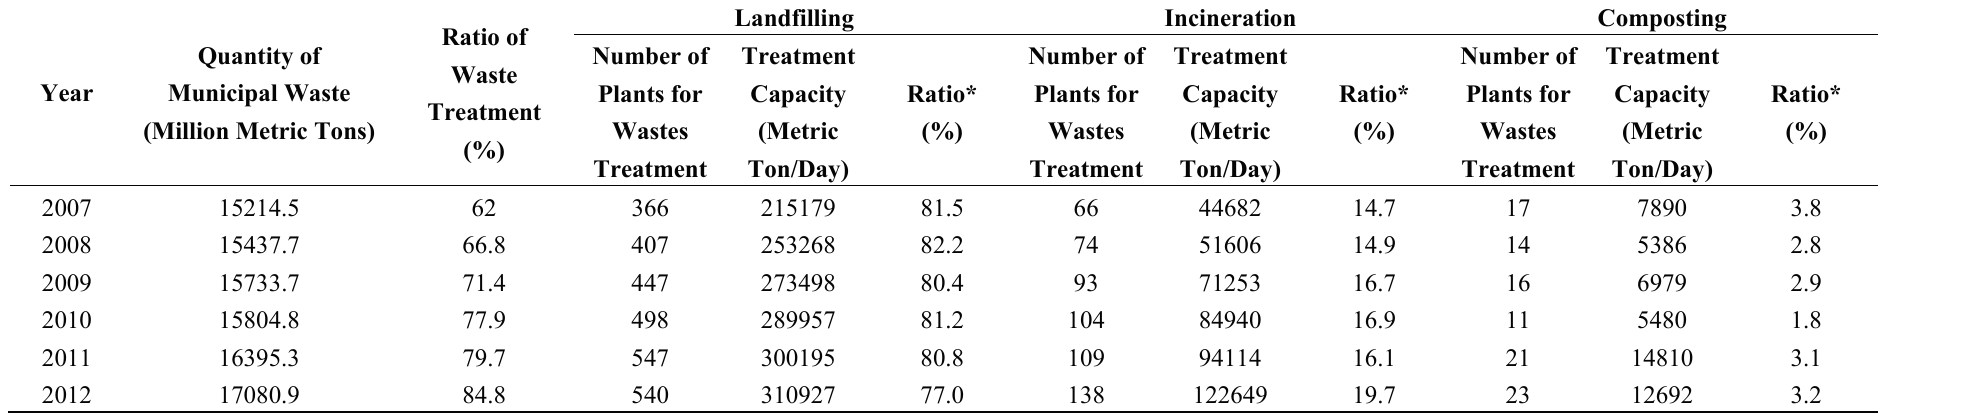
Table 1. Statistics of municipal waste in